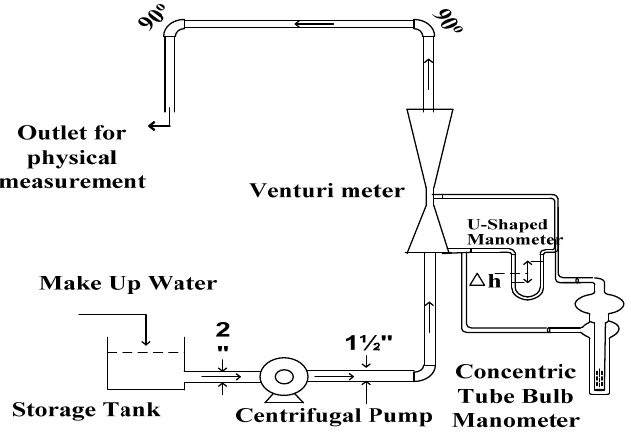
Figure 2. Experimental rig for studying the impact of variation of mass flow rates on difference in heights alternatively for both U-shaped and C.T.B manometers installed across orifice meter.